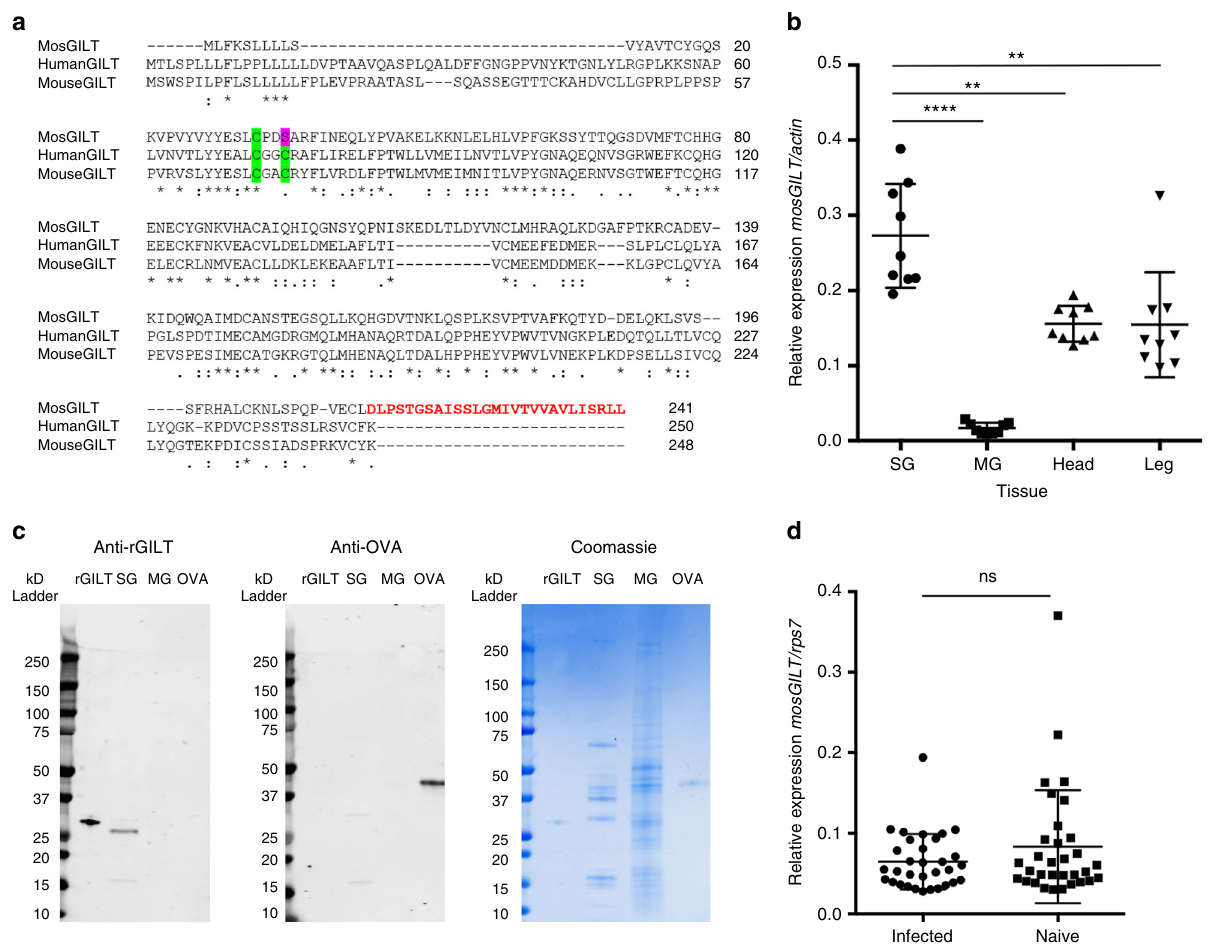
Fig. 2 AGAP004551 (mosGILT) is a gamma interferon inducible lysosomal thiol reductase-like protein expressed in mosquito salivary glands. a An alignment of the A. gambiae AGAP004551 (mosGILT) sequence with the human GILT and mouse GILT sequences (Key * -conserved residues, : -strongly similar residues, . -weakly similar residues). The active site cysteines of mosquito, human, and mouse GILT are highlighted in green and the mosGILT active site serine in pink. The C-terminus of mosGILT is highlighted in bold red. b RT-qPCR of mosquito tissues (data pooled from three independent experiments, each point represents three mosquito tissues, mean ± standard deviation (SD), n = 9/group, unpaired t -test, ** p < 0.005, **** p < 0.00001). c Western blots and SDS-PAGE of mosquito salivary glands (SG) and midguts (MG). Western blots were probed with polyclonal mouse anti-rGILT (recombinant mosGILT) or mouse anti-Ovalbumin sera (OVA) as a control at 1:1000 dilutions (kilodaltons, kD). d RT-qPCR of P. berghei infected and naive salivary glands. Each point represents an individual mosquito salivary gland (data pooled from four independent experiments, n = 32/group, mean ± SD, ns